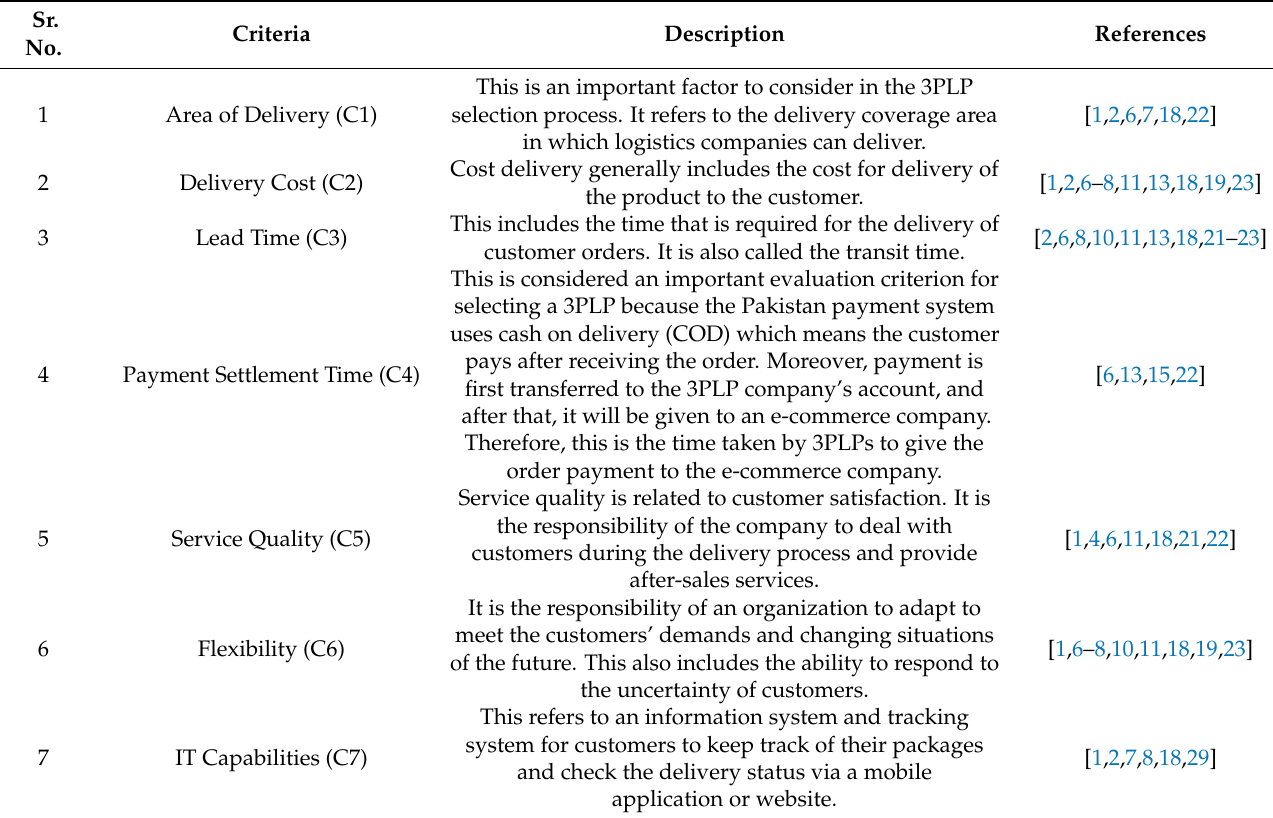
Table 1. List of criteria used in third-party logistics provider selection.